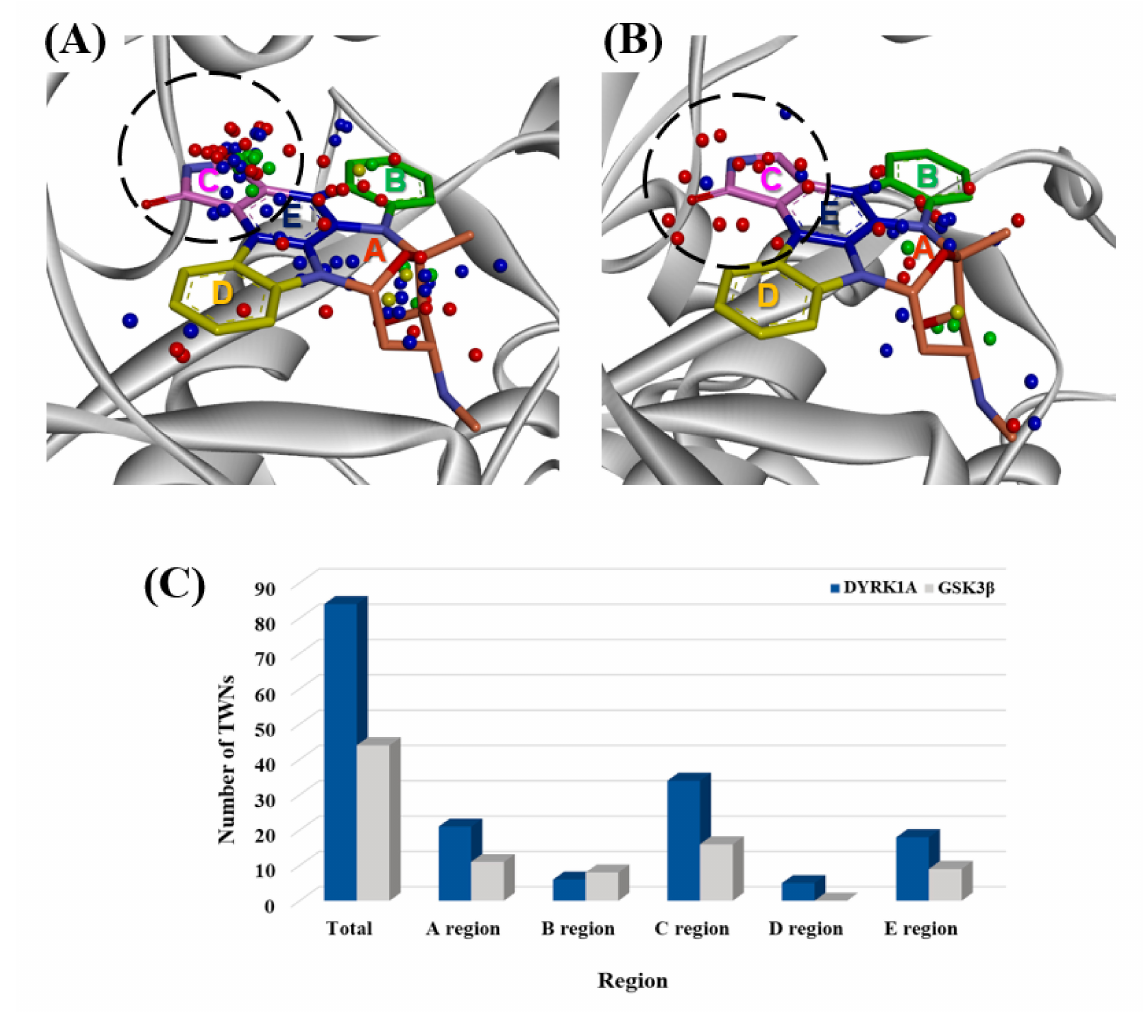
Figure 2. Superposition of staurosporine (pink stick model) with the center of mass of TWNs for ( A ) DYRK1A and ( B ) GSK3 β . Center of masses of R3, R4, R5, and R6 TWNs are shown as red, blue, green, and yellow spheres, respectively. TWNs within the C region of the ATP binding site are highlighted with a sky-blue circle. ( C ) Distribution of TWNs are in various regions of the ATP binding